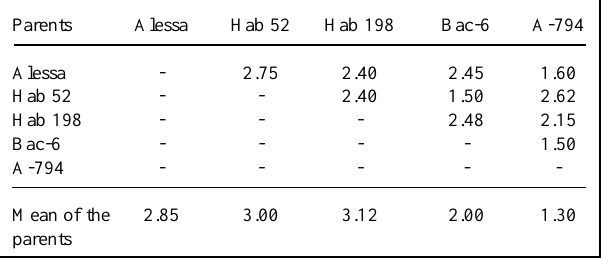
Table I - Mean values for parent and F1 hybrid reactions to common bacterial blight infection in Phaseolus vulgaris L. leaves measured on a scale of 1 to